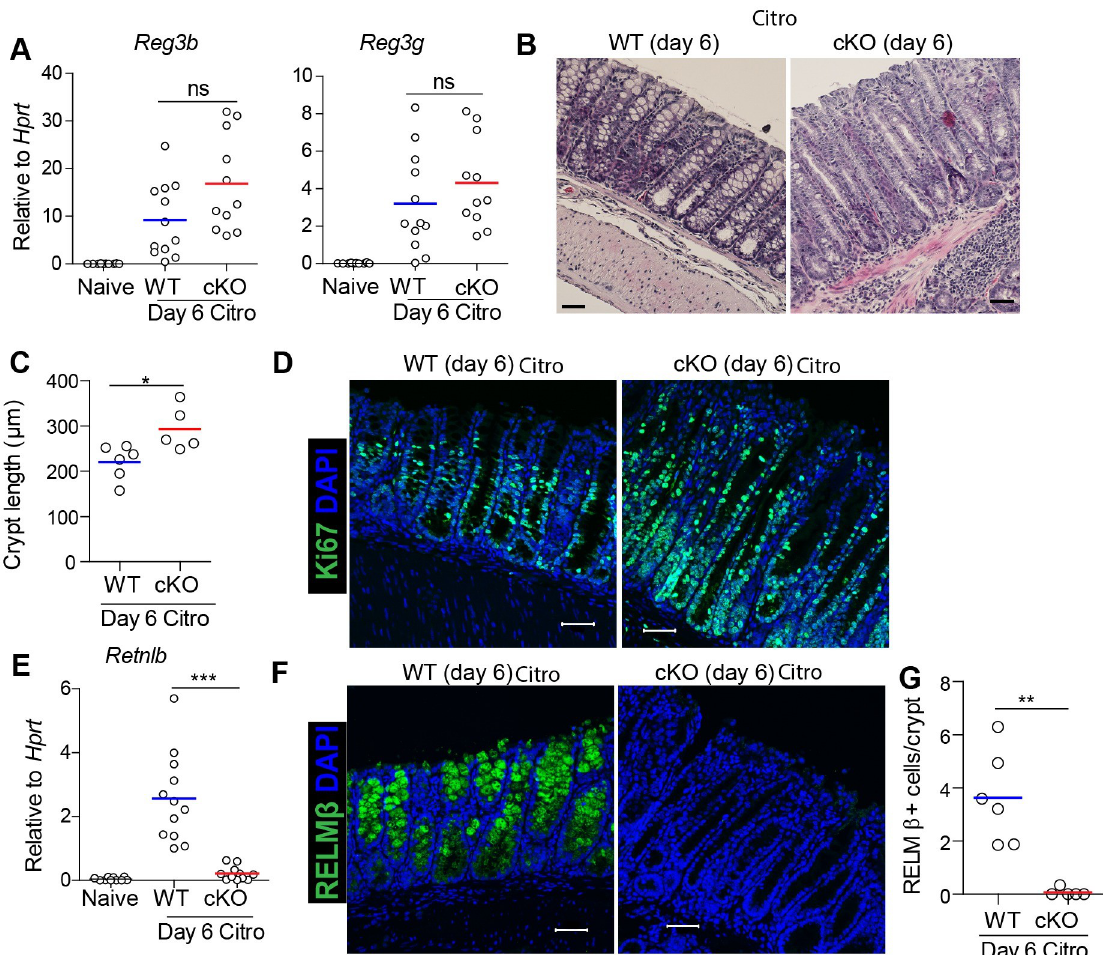
Fig 3. Intestinal-epithelial LSD1 is required for appropriate crypt hyperplasia and goblet cell responses to infection with C . rodentium . (A) RT-qPCR for antimicrobials Reg3b and Reg3g in colon tissue of Naive (WT n = 10), and WT (n = 12) and cKO (n = 11) mice infected with C . rodentium for 6 days. (B&C) H&E staining and quantification of crypt length at distal colon in WT (n = 6) and cKO (n = 5) mice infected with C . rodentium for 6 days (scale bar = 50 μ m). (D) Ki67 staining to measure proliferation in distal colon tissue of WT and cKO mice infected with C . rodentium for 6 days. (E) RT-qPCR for goblet-cell specific antimicrobials Retnlb in colon tissue of Naive (WT n = 10), WT (n = 12) and cKO (n = 11) mice infected with C . rodentium for 6 days. (F&G) Representative confocal images and quantification of RELM β + cells (green) in distal colon tissue of WT (n = 6) and cKO (n = 5) infected mice. DAPI (blue) was used as a nuclear counter stain. Scale bar = 50 μ m. Unpaired two-tailed Student’s t test (A, C, E & G) was performed to observe significant differences among experimental groups. ns = not significant, � P � 0.05, �� , P < 0.01, ��� P � 0.001. Each dot represents one mouse and means are